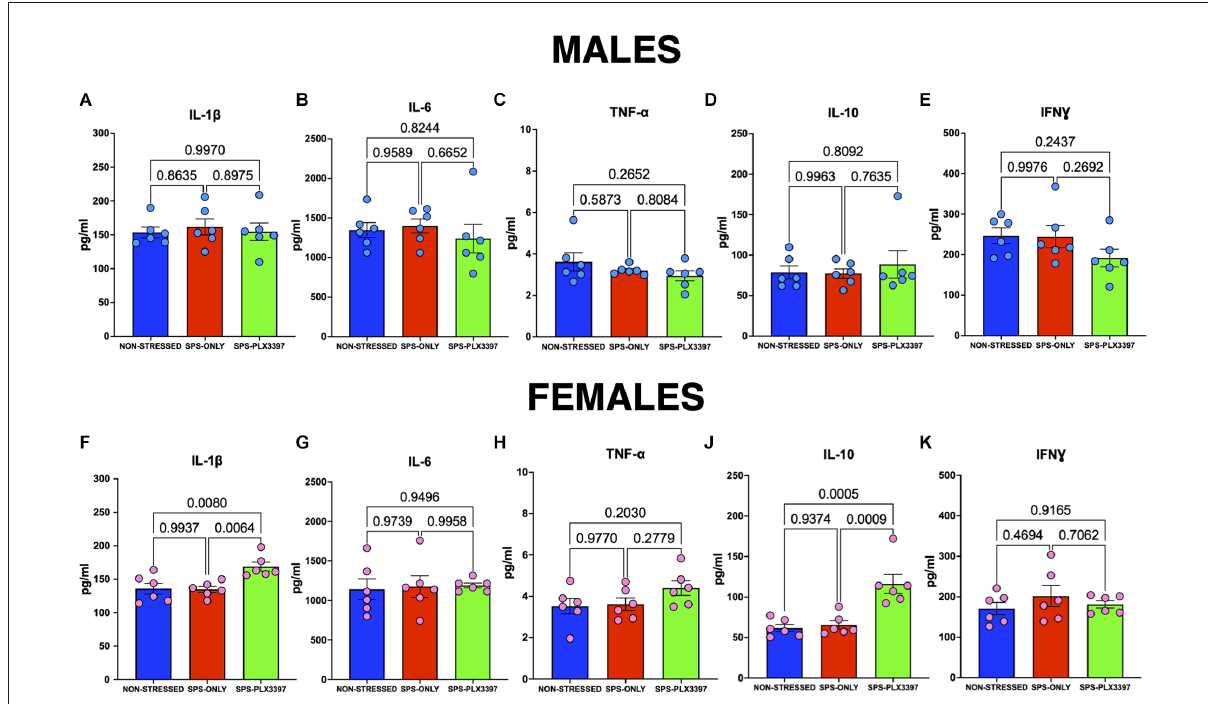
FIGURE4 PLX3397 treatment increases hippocampal IL-1 β and IL-10 in females, but not in male rats . (A–E) Hippocampal cytokine expression of male rats. (F–K) Hippocampal cytokine expression of female rats. One-way ANOVA, Tukey’s multiple comparisons